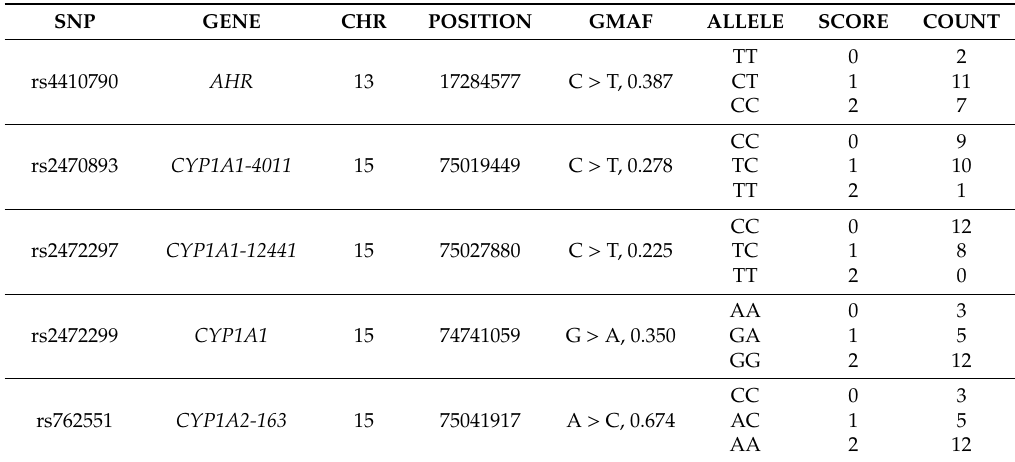
Table 4. Combined Ca ff eine Sensitivity Allele